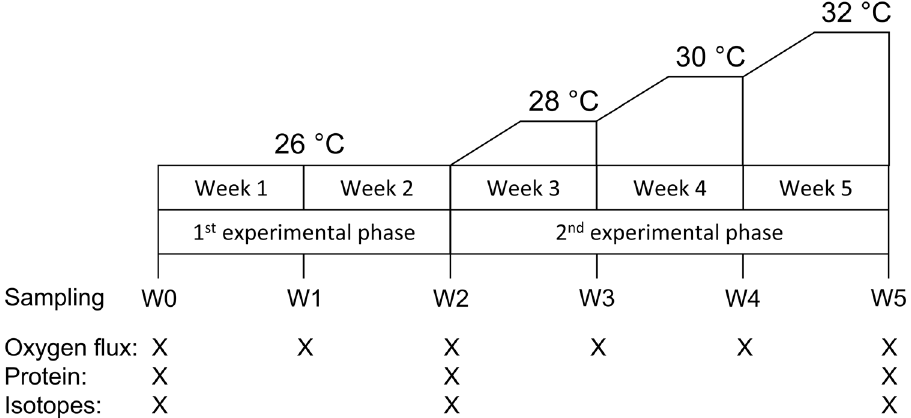
Figure 1. Experimental design with a 1st experimental phase of pure PO 4 enrichment, followed by a 2nd experimental phase during which temperature was increased stepwise from 26 to 32 °C. Sampling of oxygen fluxes took place after each week (W0-5), while corals for protein content as well as elemental and stable isotope analysis were collected at the beginning, and at the end of each experimental